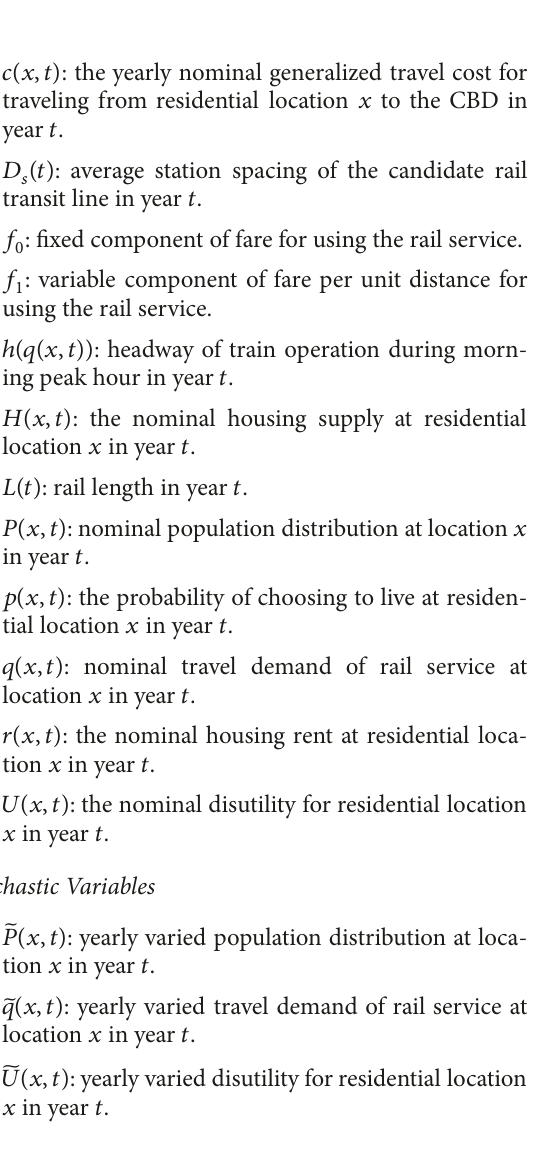
Figure 1: Configuration of a candidate rail line over years in a linear monocentric